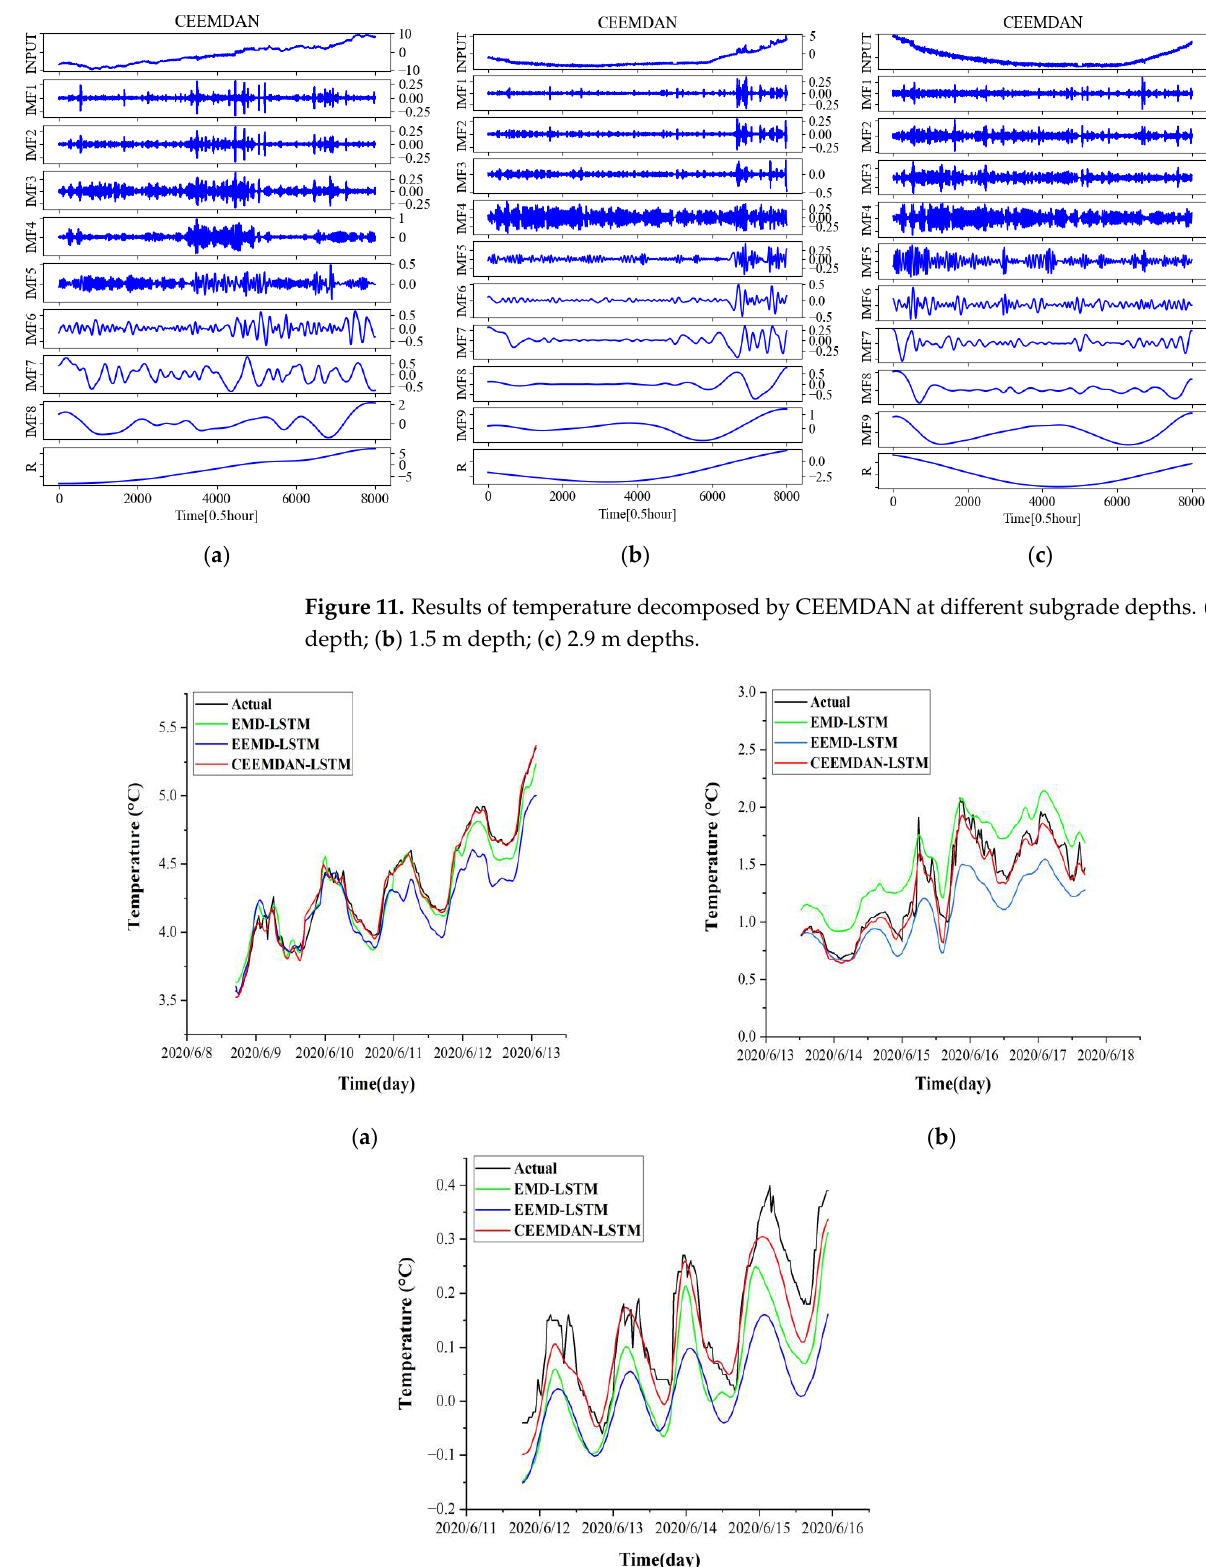
Figure 12. Comparison of model prediction results for different subgrade depths of the right shoulder. ( a ) 0.5 m depth; ( b ) 1.5 m depth; ( c ) 2.9 m depth.